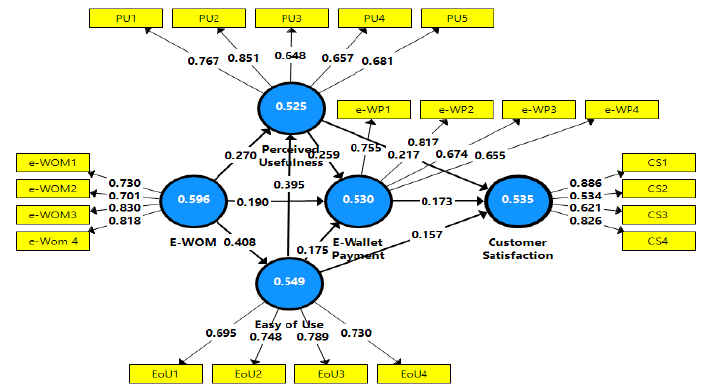
Fig. 2. Path Coefficient of the resulting